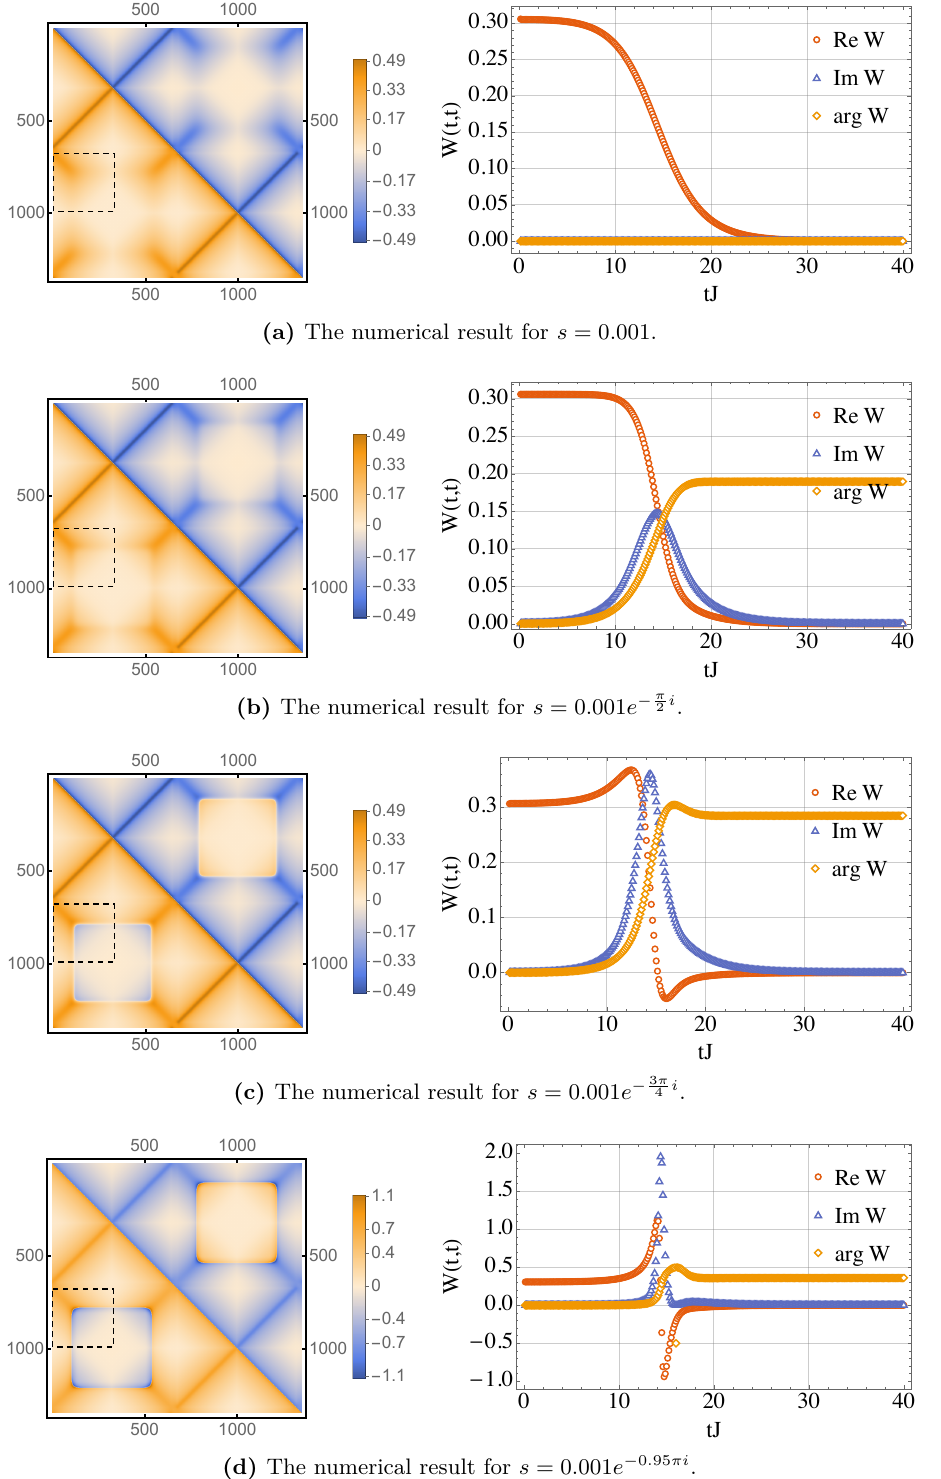
Figure 7. Numerical results for the q = 4 model with βJ = 8 and tJ = 40 . The color plots on the left show Re G ( l, l 0 ) ; the area representing W is marked by the dashed box. On the right, arg W is plotted in units of 2 π